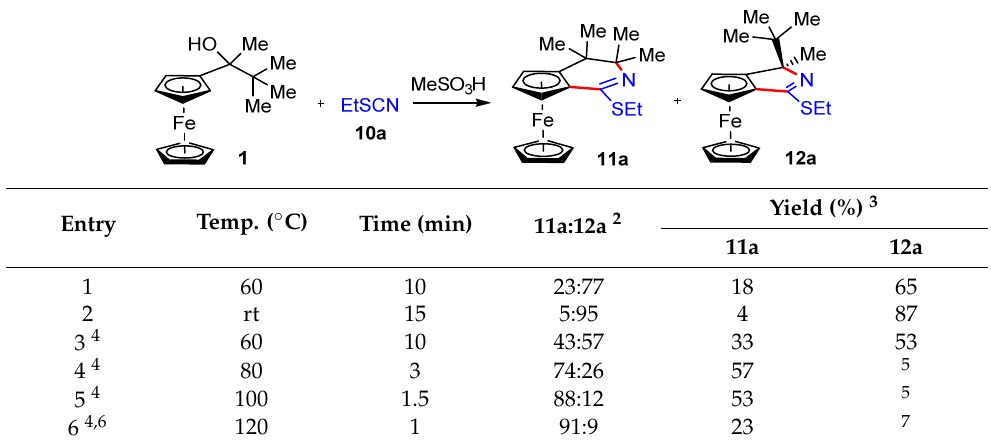
Table 4. Reaction of alcohol 1 with EtSCN ( 10a ). 1